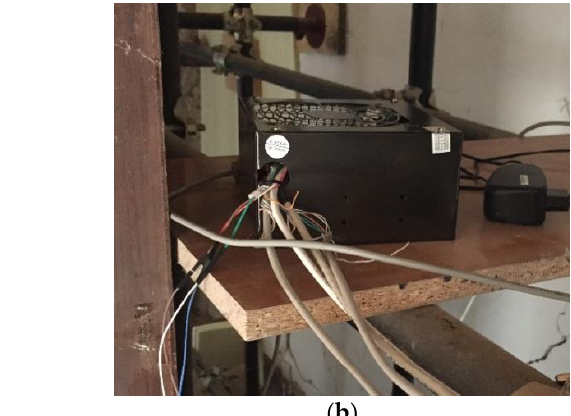
Figure 4. Scheme of the duct route through the floors (basement–ground–first floors). The materials used are steel and rock wool.